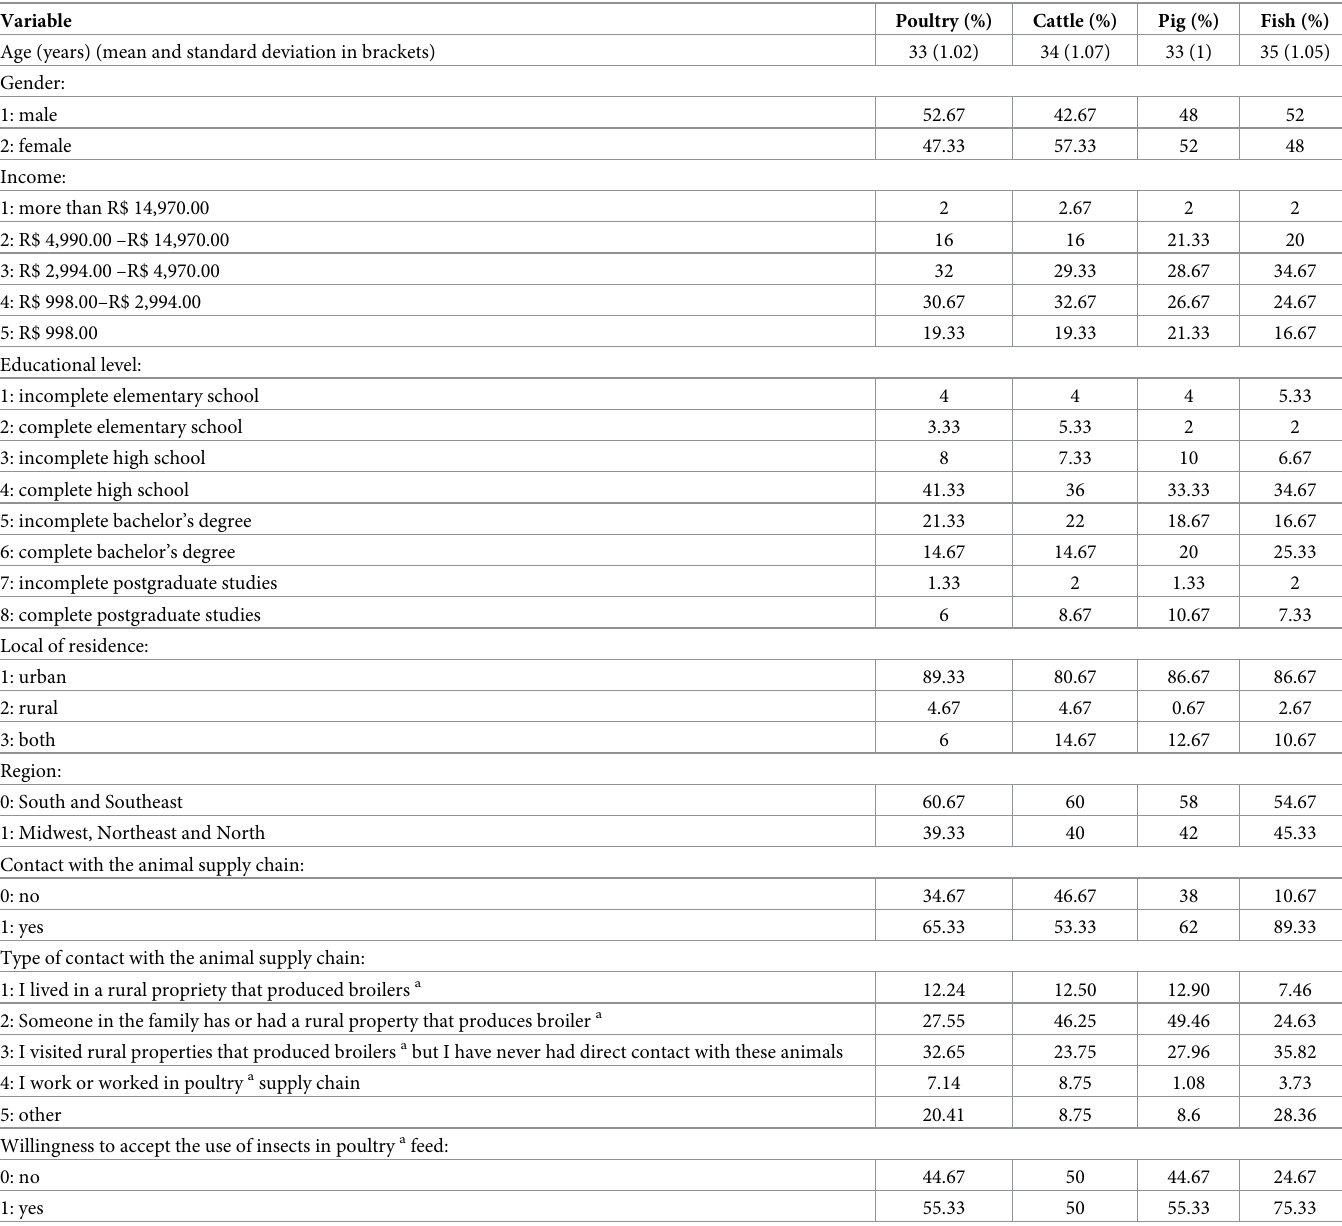
Table 1. Descriptive statistics of the socio-demographic and ‘willingness to accept’ variables used in the poultry, cattle, pig and fish questionnaires. Variable Poultry (%) Cattle (%) Pig (%) Fish (%) Age (years) (mean and standard deviation in brackets) 33